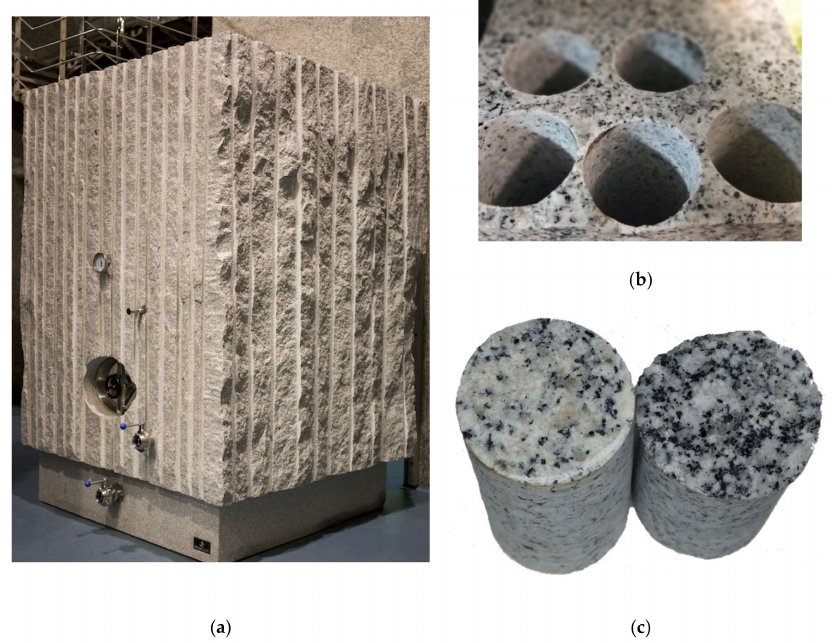
Figure 8. ( a ) View of a granite tank in Mar de Frades winery (Meis, Pontevedra, Spain); ( b ) perforated granite block, and ( c ) granite pieces of the two origins tested where the difference in their composition, especially in mica of the black biotite type, can be